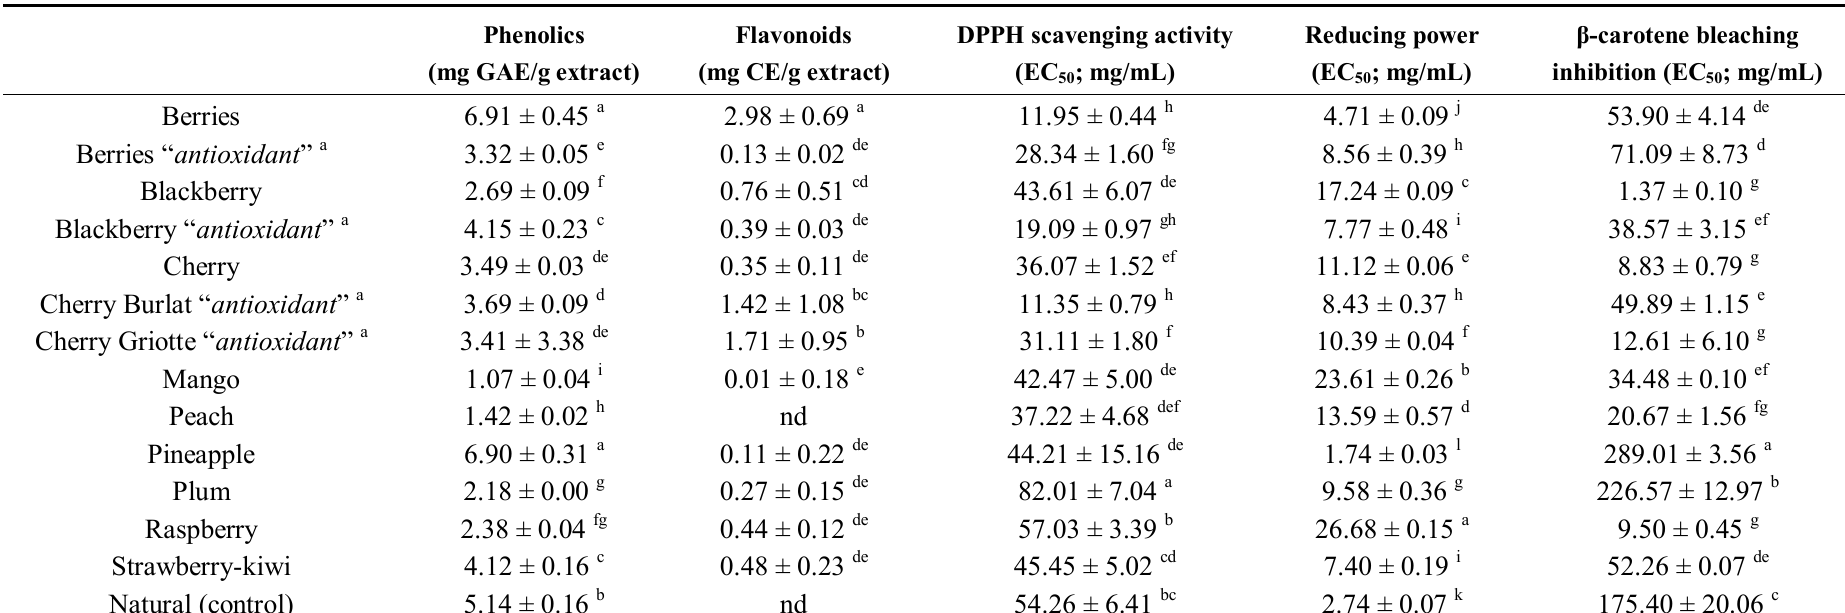
Table 2. Antioxidants content and in vitro antioxidant properties of the studied yogurts (mean ±